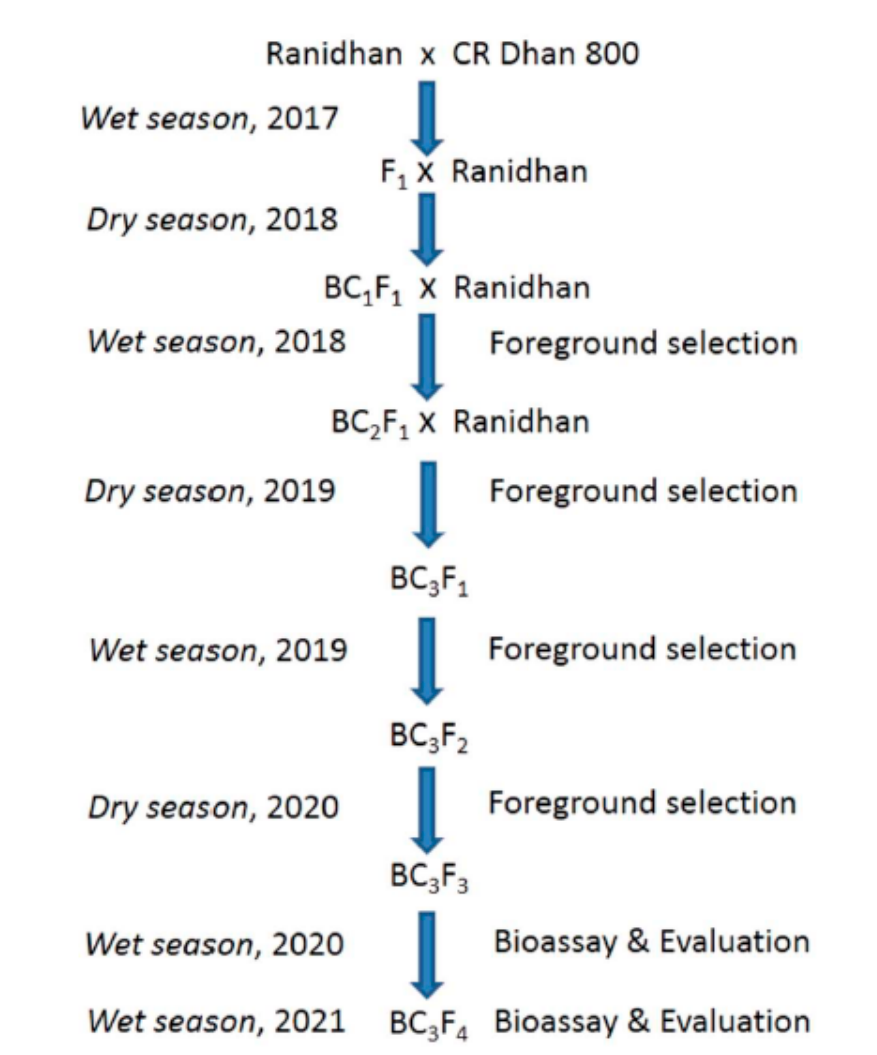
Figure 1. Marker-assisted breeding scheme for transfer of BB resistance genes into the popular variety, Ranidhan. Table 1. Markers used for the three bacterial blight resistance genes for foreground selection in the marker-assisted backcross breeding program.